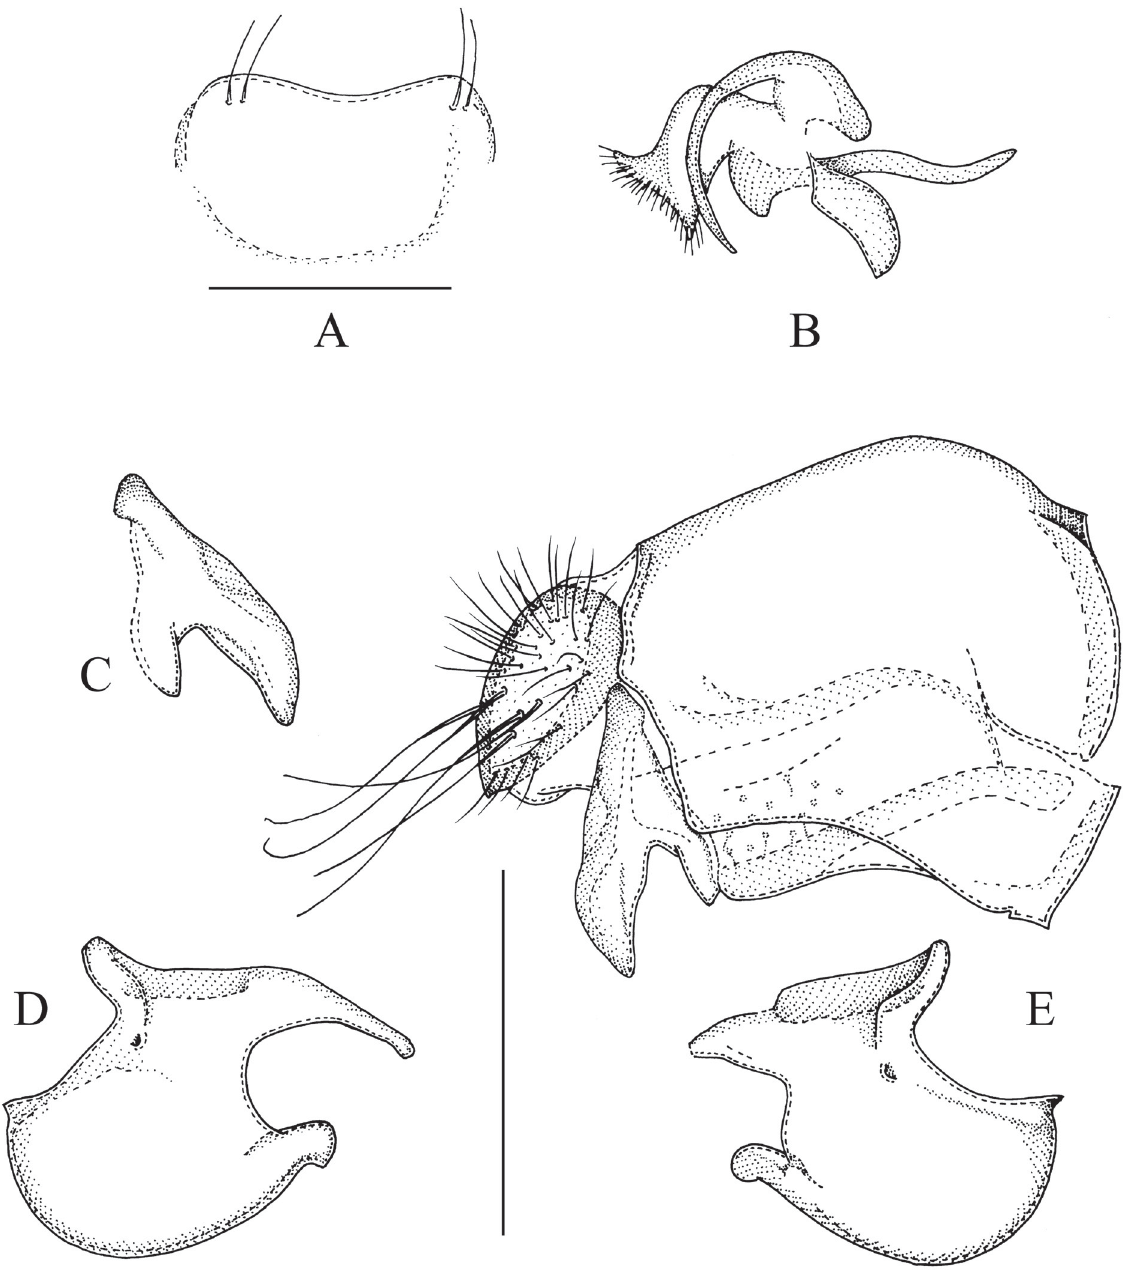
Fig. 39. Sphegina (Asiosphegina) granditarsis sp. nov., holotype, ♂ . A . Posterior part of sternum IV, ventral view. B . Aedeagus, right side latera l view. C . Left surstylus, lateral view. D . Sternum IX and superior lobe, left side lateral view. E . Genitalia right side lateral view. Scale bars =